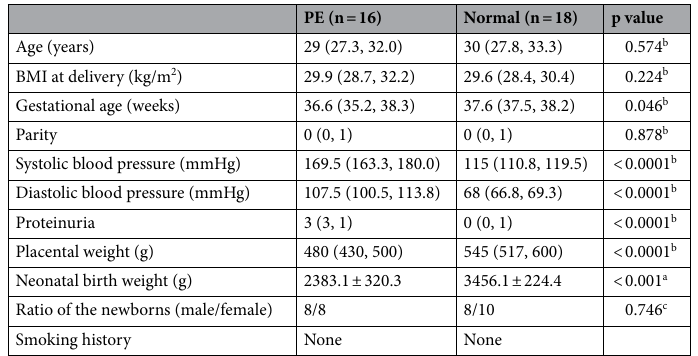
Table 1. Clinical characteristics of the participants. PE pre-eclampsia, BMI body mass index; a Student t test; b Mann–Whitney test; c Chi-squared